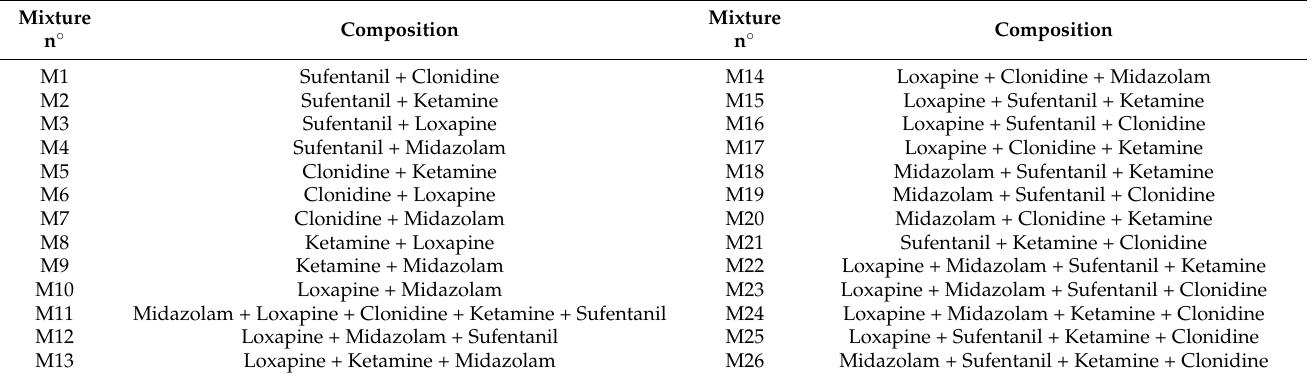
Table 2. Drugs mixtures qualitative